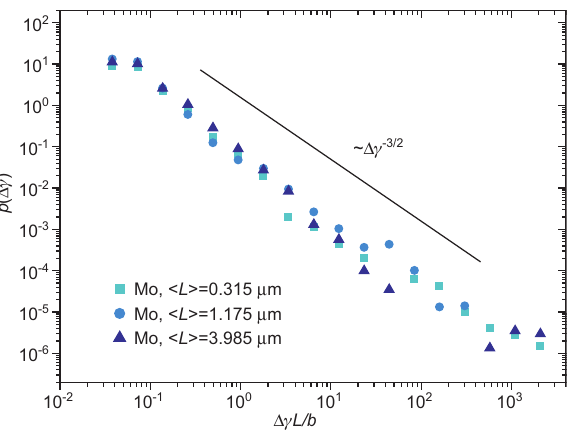
Figure 5 Probability distribution of strain increments determined in stress-controlled compression of [100]-oriented Mo micropillars of different sizes. The straight line indicates a power law distribution with exponent 3/2.